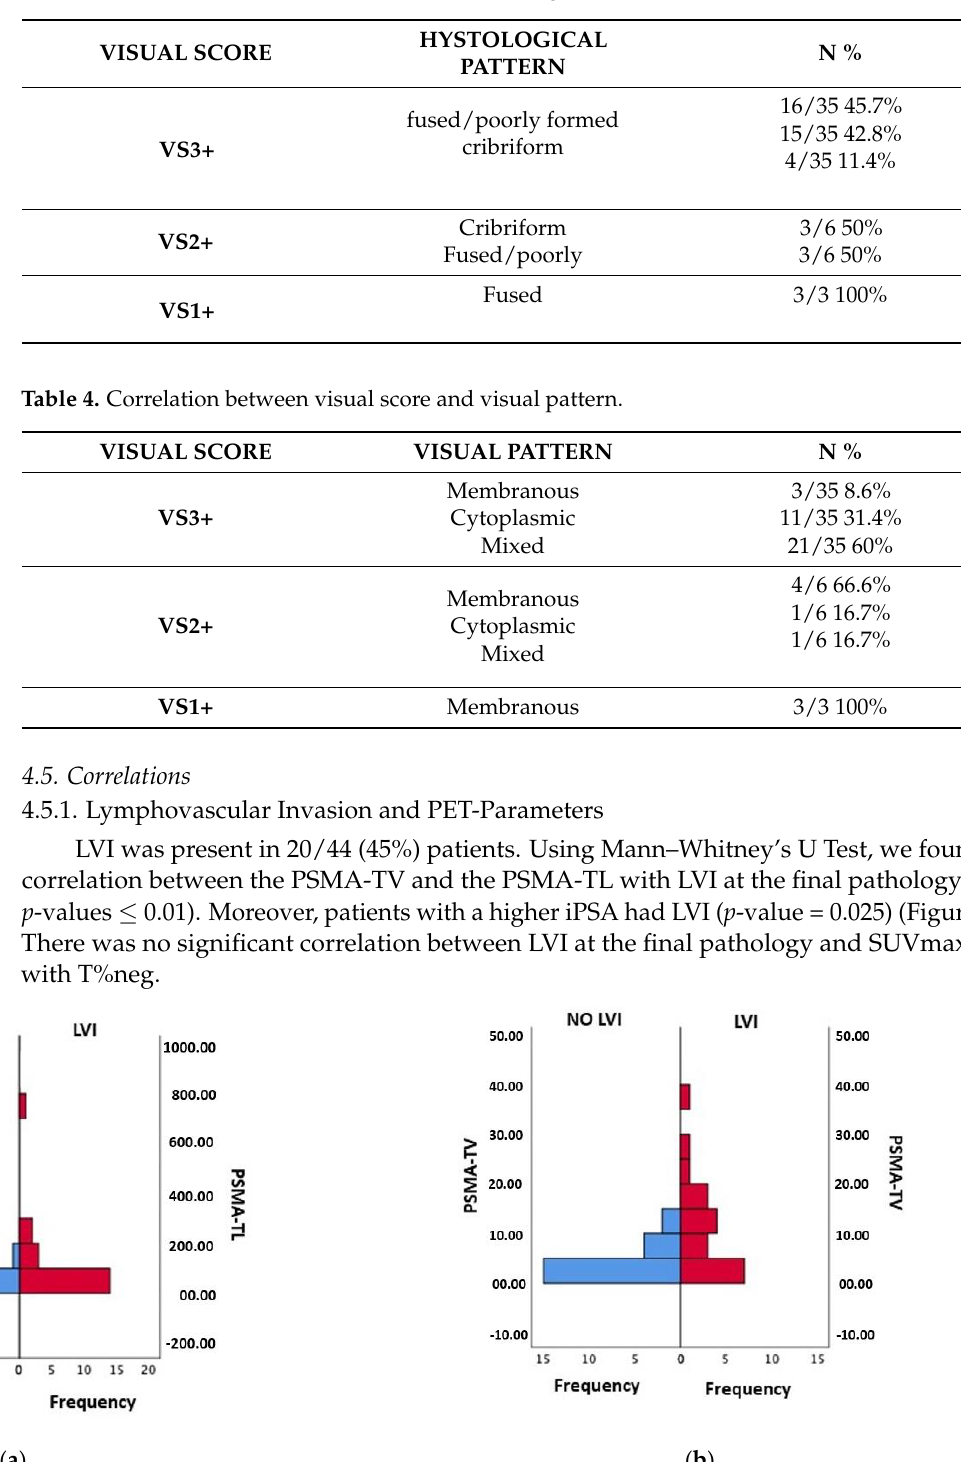
Table 3. Correlation between visual score and histological results.